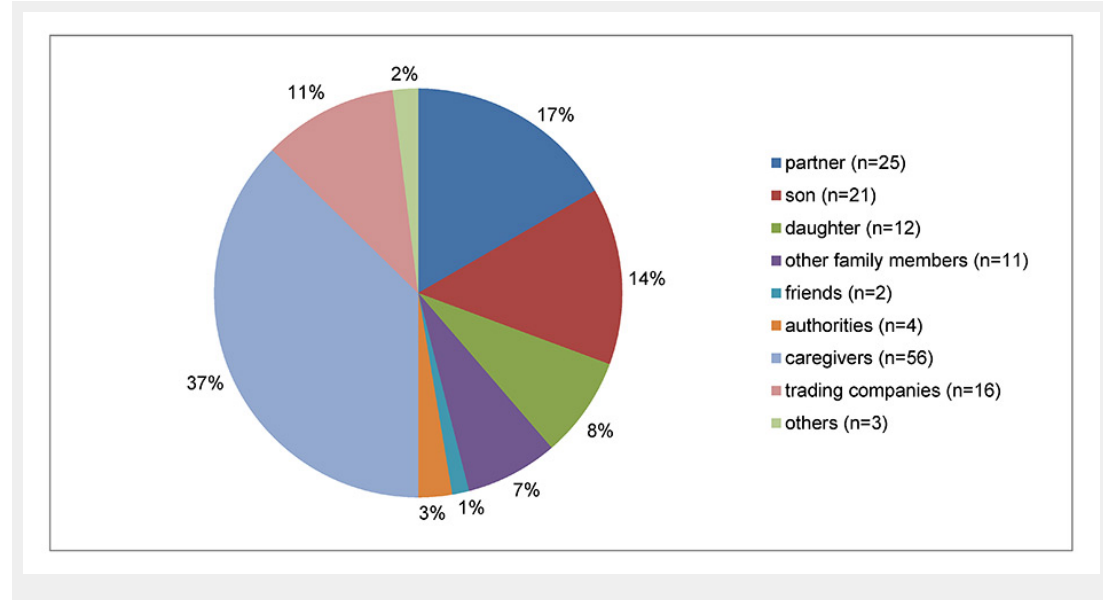
Figure 3a Perpetrators relationship to their victim.